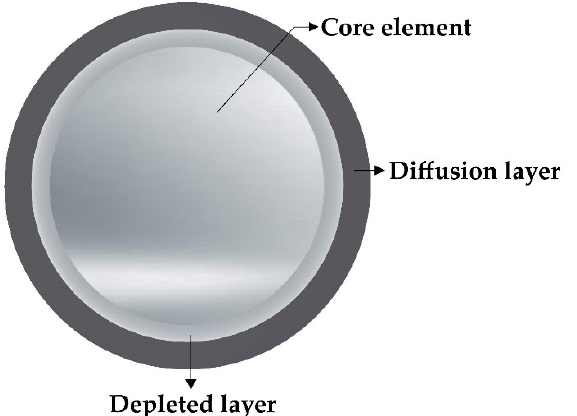
Figure 6. Schematic cross-section of a coated powder, the thickness of the different layers is not in scale.